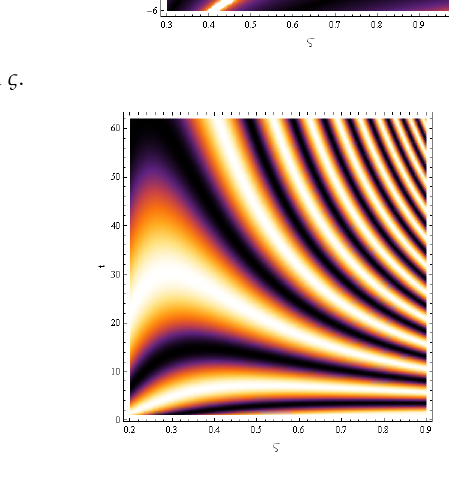
Figure 4. Variation of solution (19) versus t and ς .